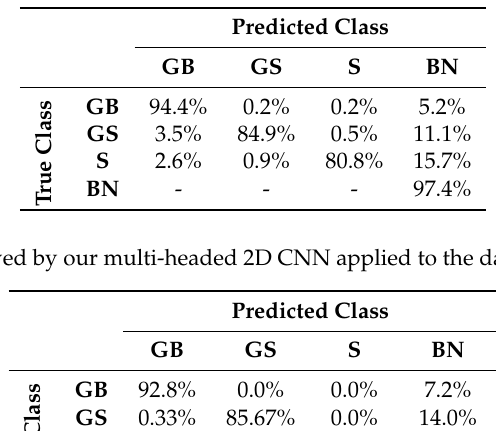
Table 3. Results reported in [8] in their database.